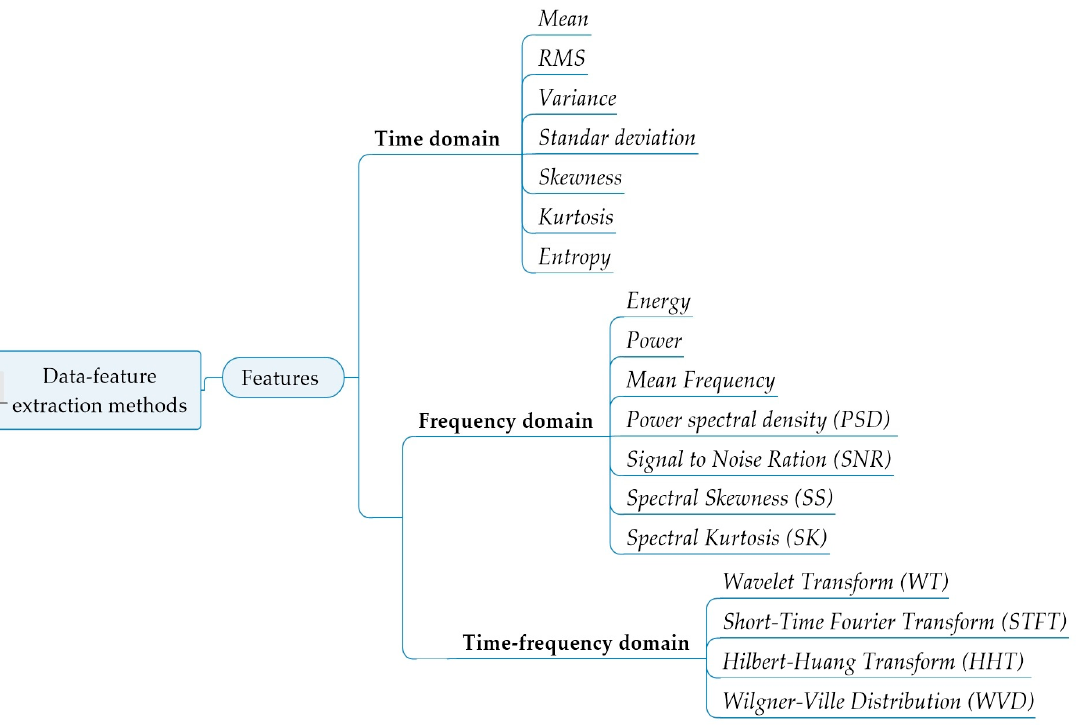
Figure 11. Data-feature extraction methods [113].